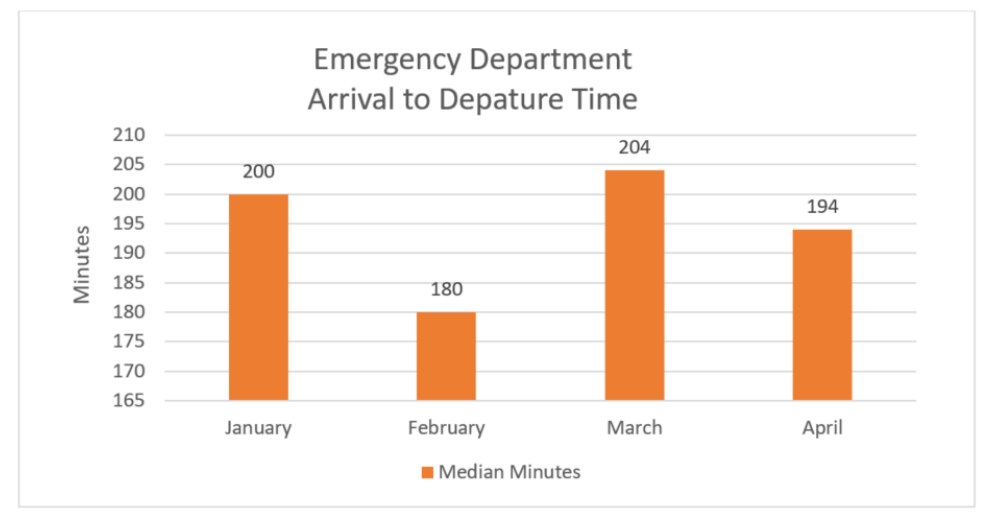
Figure 4. Emergency Department arrival to departure time, first quarter, 2021. Table 2. Emergency Department patients count and arrival to departure time.